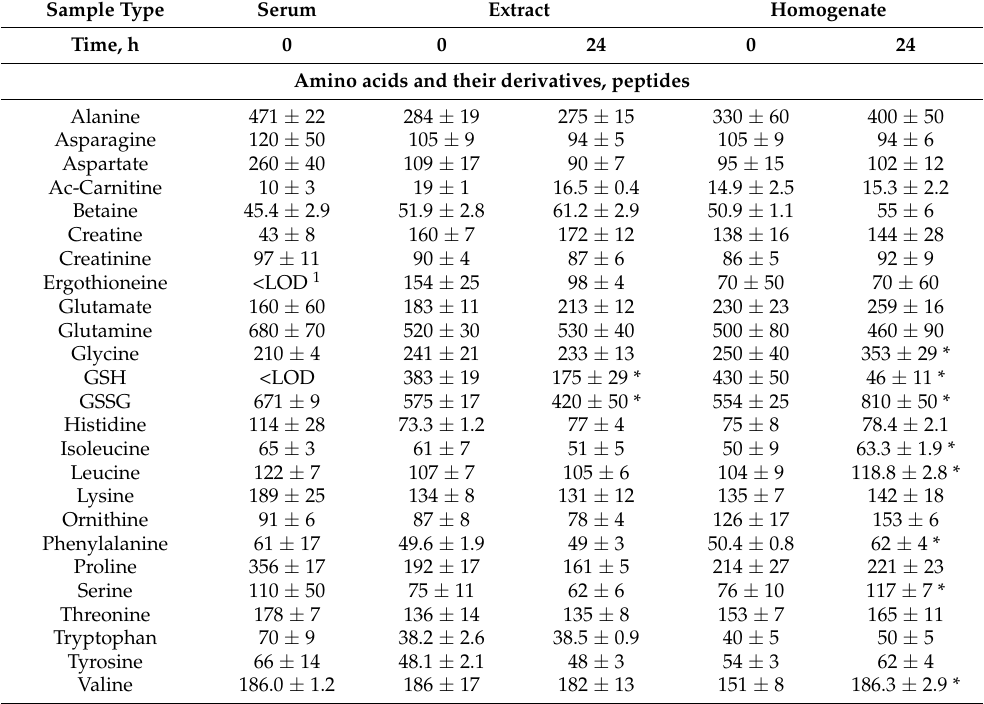
Table 1. Concentrations of metabolites (in units of µ M) in serum, whole blood extract,